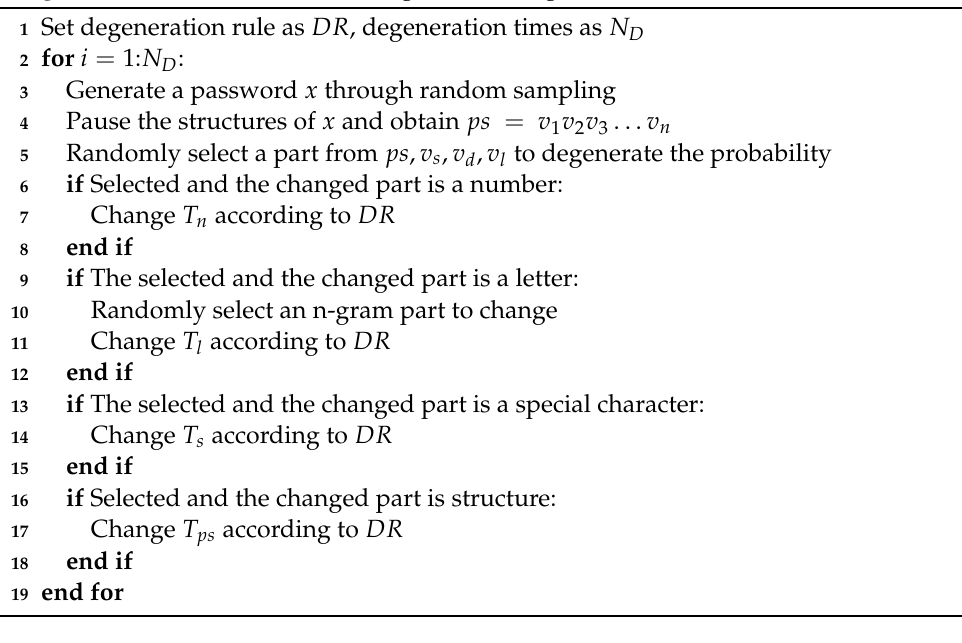
Algorithm 2: LPG–PCFG model degeneration algorithm.